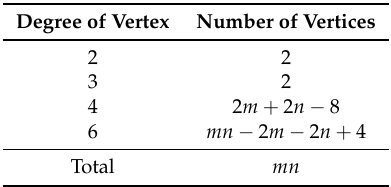
Figure 1. Graph of the Tickysim SpiNNaker Model sheet for m = n = 12. Table 1. The vertex partition of the graph TSM sheet based on the degree of